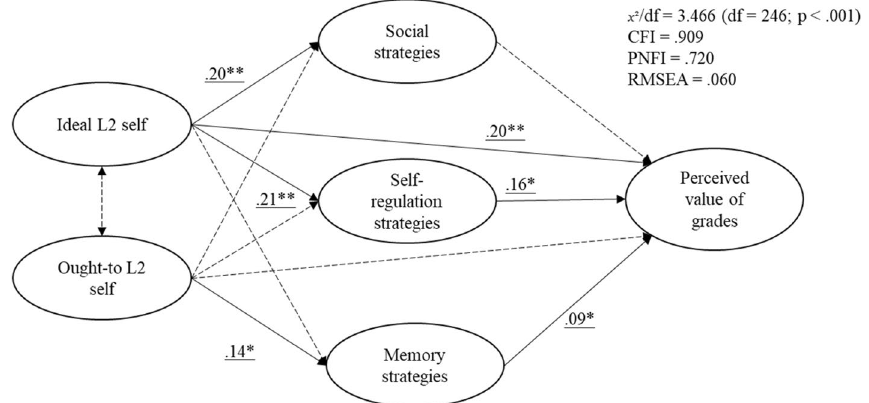
Fig. 4 Path analysis and path coefficients of the impacts of possible L2 selves and language learning strategies on students’ perceived value of